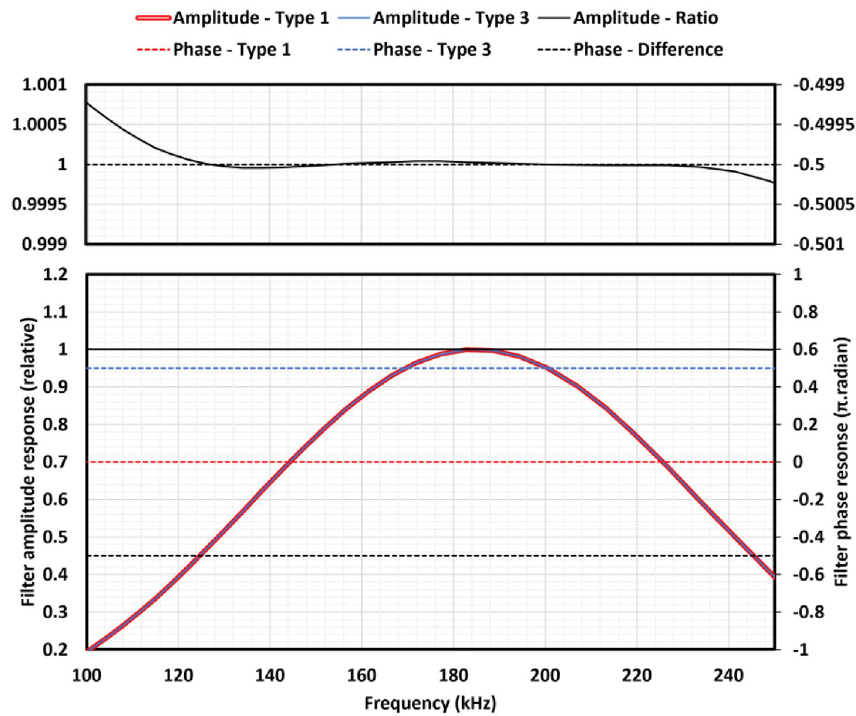
Figure 5. Calculated results for the amplitude and phase frequency response of the dual FIR filters, including the effects of fixed-point signal representation. The solid curves show the relative amplitude response of the matched type 1 (red) and type 3 (blue) filters, and the ratio of their amplitudes (black). The dashed lines show the phase shift of the type 1 (red) and type 3 (blue) filters, along with their difference (black). The upper plot shows the amplitude ratio and phase difference in detail. Note that the phase difference is fixed to π/ 2 radian by filter coefficient